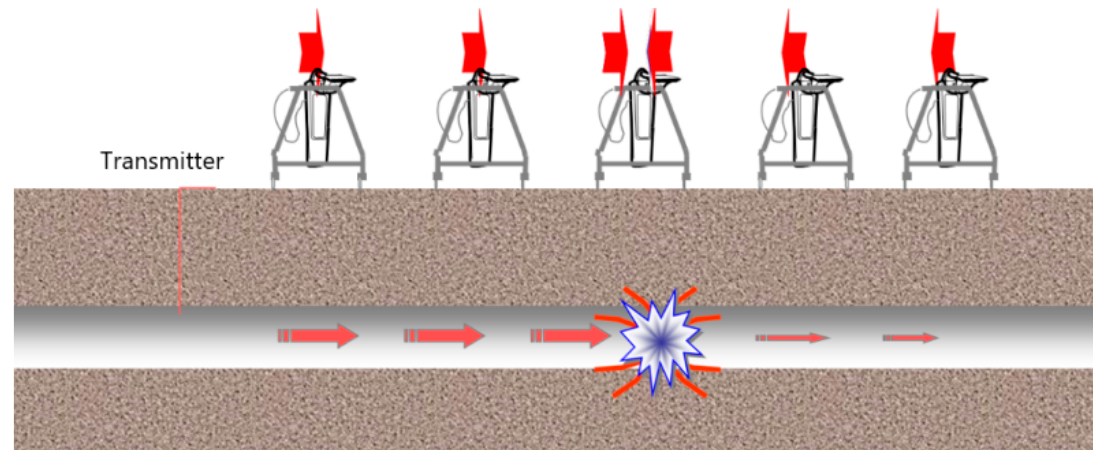
Figure 9. Principles of A-frame gauge for damage detection.